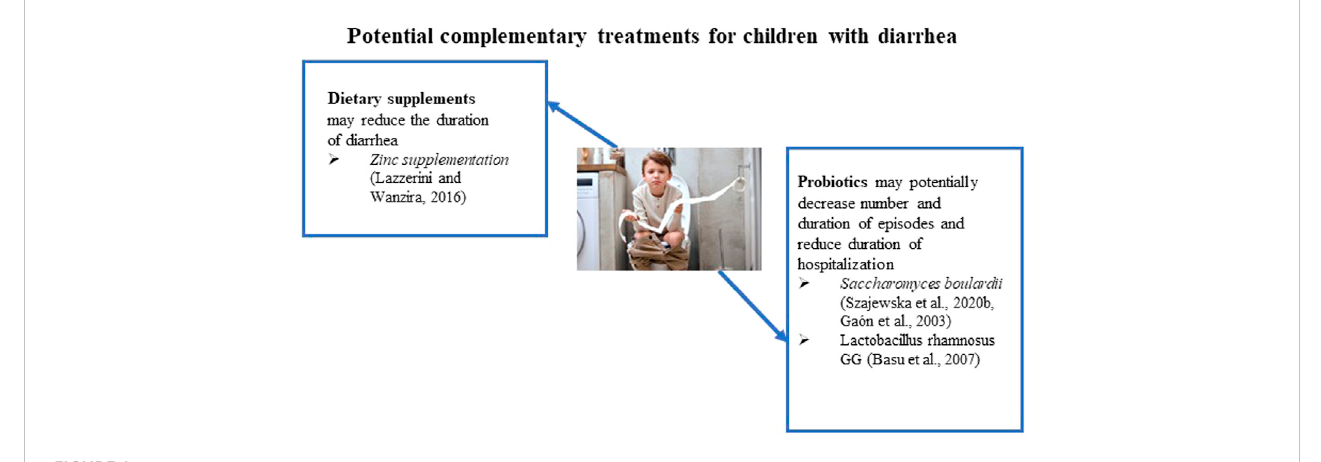
FIGURE 1 Potential complementary treatments for children with